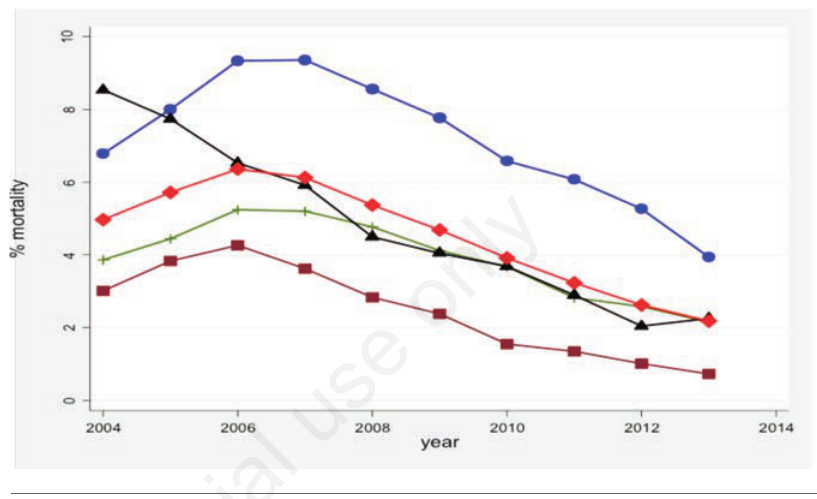
Figure 1. Mean annual mortality expressed as a percent of HIV positive patients reported dead out of the total number in care per month at each of the four clinics: Tororo HIV